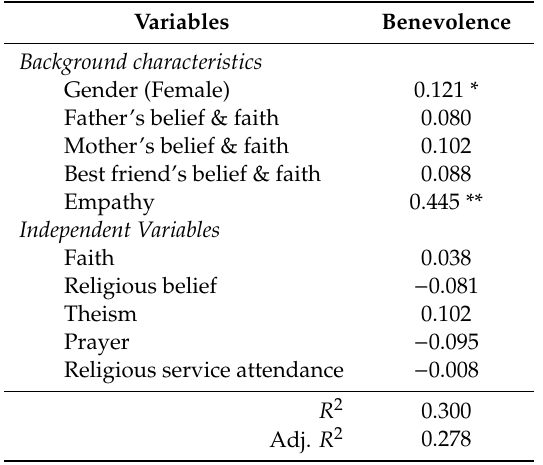
Table 4. Regression analysis for benevolence with weights ( β ) for each variable and total explained variance ( R 2 and adjusted R 2